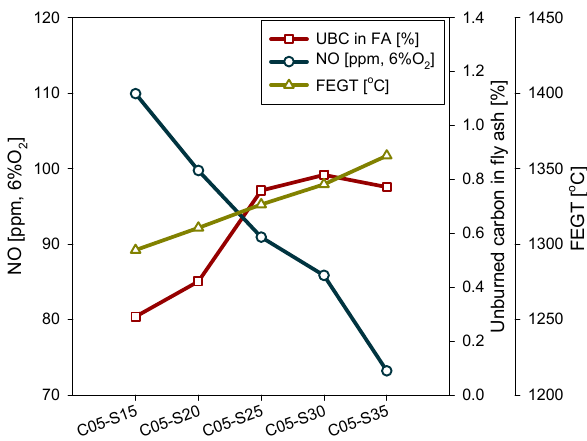
Figure 8. Comparison of NOx emission, unburned carbon (UBC) in fly ash, and furnace exit gas temperature (FEGT) for di ff erent SOFA ratios (CCOFA ratio fixed at 5%).